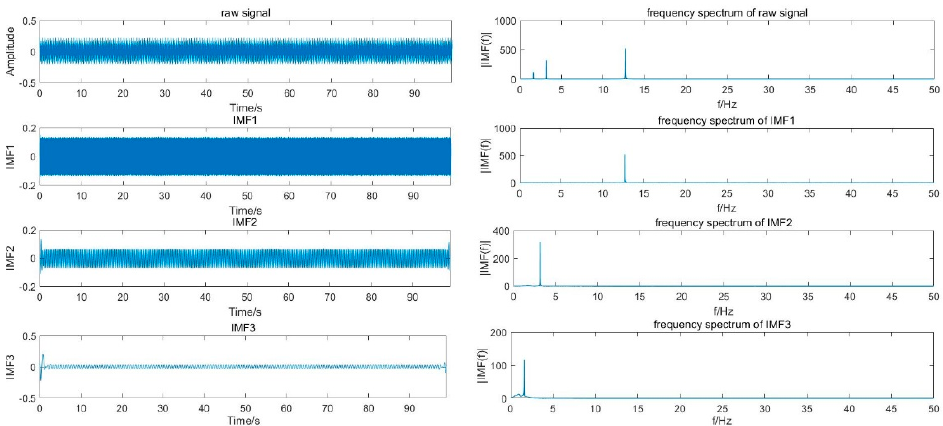
Figure 2. Time-dependent chart and frequency spectrums of vibration signals and intrinsic mode functions (IMFs) by ensemble empirical mode decomposition (EEMD).